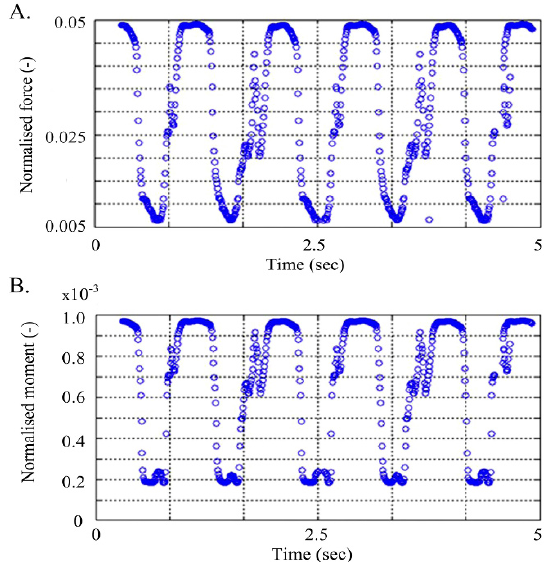
Figure 10. A. The diagram of predicted muscle force; B. The diagram of predicted muscle moment of the musculus gastrocnemius medialis of children with cerebral